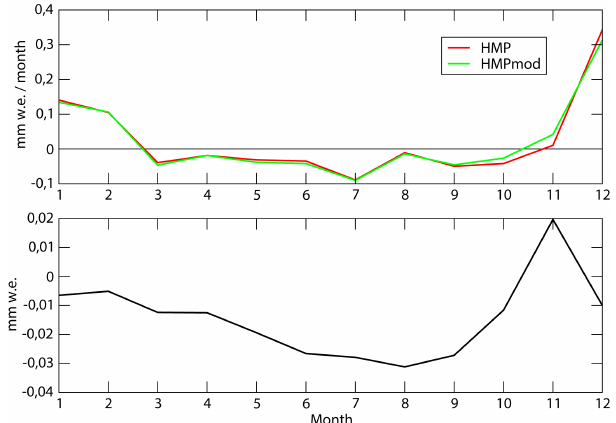
Figure 11. According to HMPmod, relative humidity versus water vapor partial pressure, saturation shown by the red line (upper plot), and probability distribution function of RH i above 105% with re- spect to water vapor partial pressure (lower